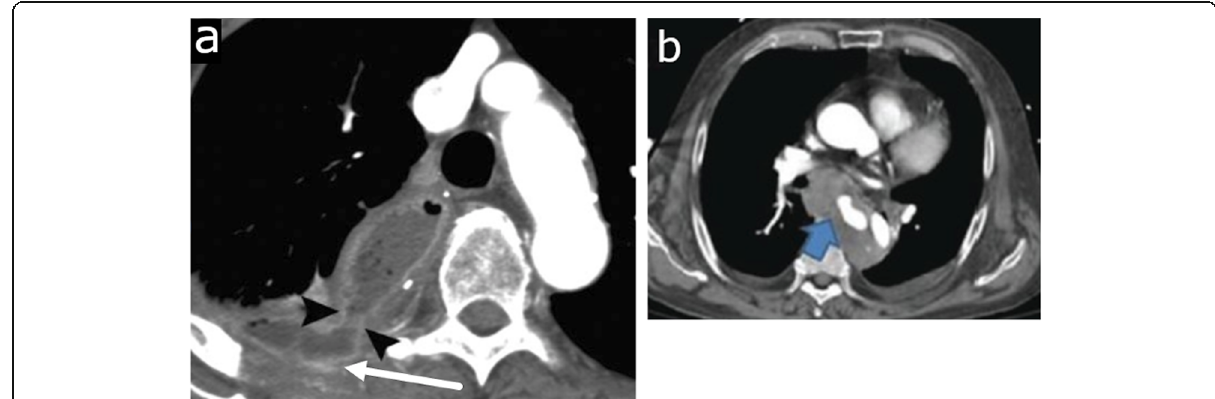
Fig. 5 Esophageal fistulas. a Esophago-pleural fistula in a 61-year-old male with squamous cell carcinoma of mid esophagus, status post esophagectomy and gastric pull through presenting with fever. Axial CT image obtained 12 days after surgery shows a fistula (arrowheads) between the gastric tube and the right pleural space. Fluid collection with pleural enhancement and thickening (arrow) is suspicious for empyema. Reprinted with permission from Kim et al. Radiographics 2007; 27(2):409-429. b Aorto-esophageal fistula in a 70-year-old male patient with hypertension and regular alcohol use presenting with hematemesis and melena. Axial image of CT chest angiography shows type B aortic dissection with rupture, communication, and extravasation between aorta and esophagus (blue arrow) in the arterial phase. Reprinted from